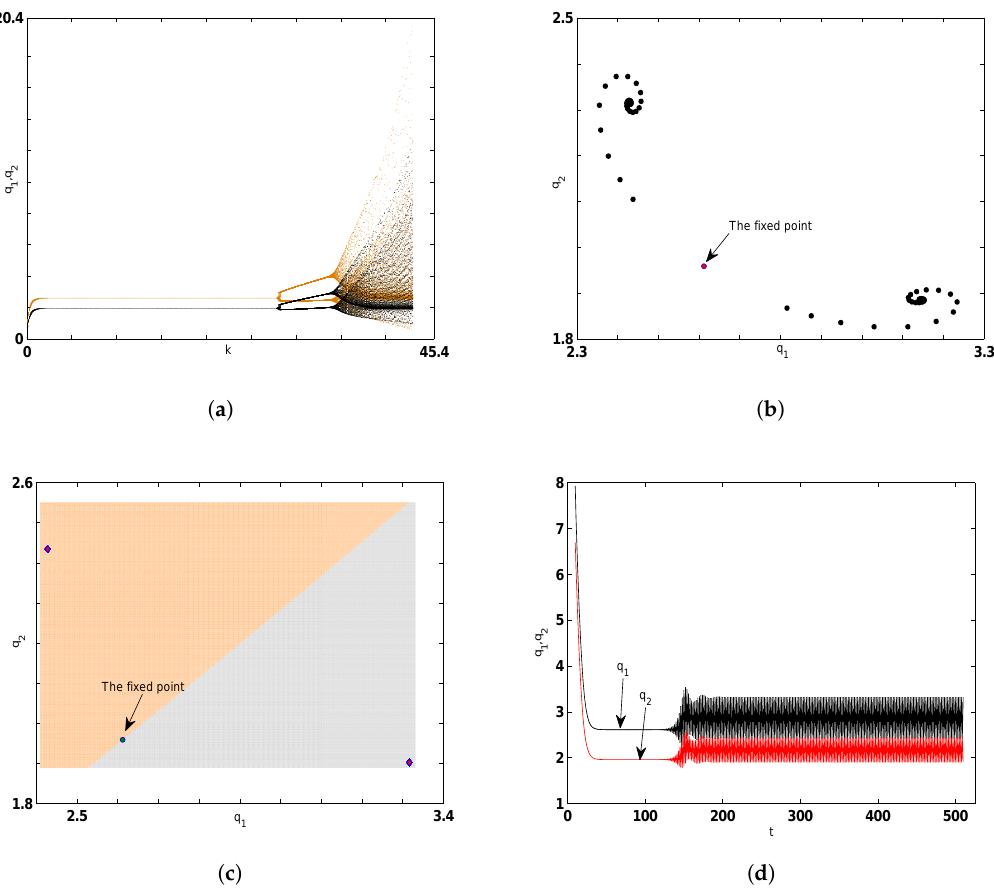
Figure 6. ( a ) bifurcation diagram of q 1, t and q 2, t when varying k ; ( b ) phase portrait of two spirals at k = 29; ( c ) Basin of Attraction of period 2-cycle at k = 29.9; ( d ) time series for both variables for the stable period 2-cycle in ( c ) at k =